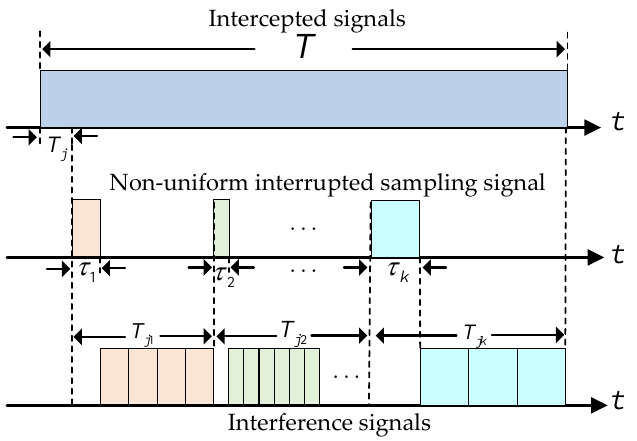
Figure 1. Schematic diagram of